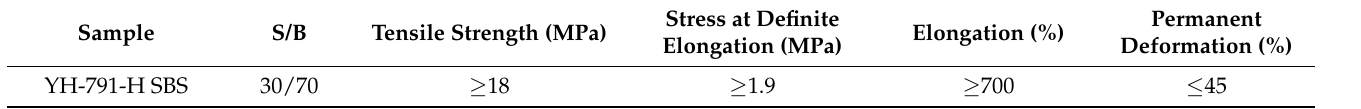
Table 4. Basic technical indicators of rice husk biochar.